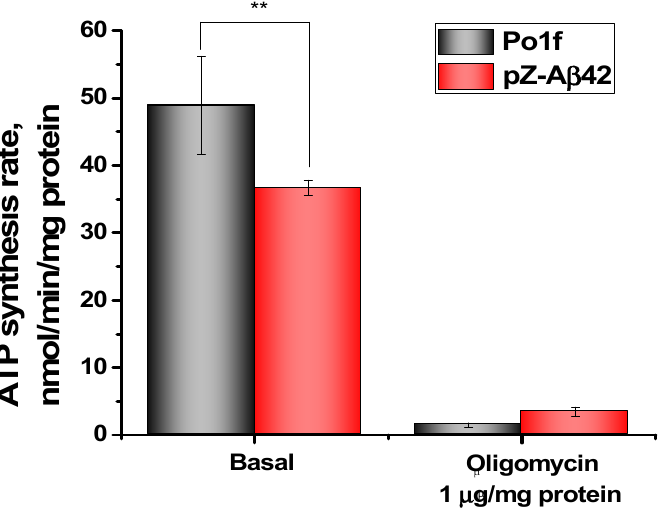
Figure 7. ATP production by Y. lipolytica mitochondria. The basic incubation medium was supplemented with 20 mM Tris-pyruvate + 5 mM Tris-malate, 5 µM Phenol Red, 6 µM Ap5A, and mitochondria (0.2 mg protein/mL). The statistical analyses were carried out by one-way ANOVA. ** 0.001 < p < 0.01.